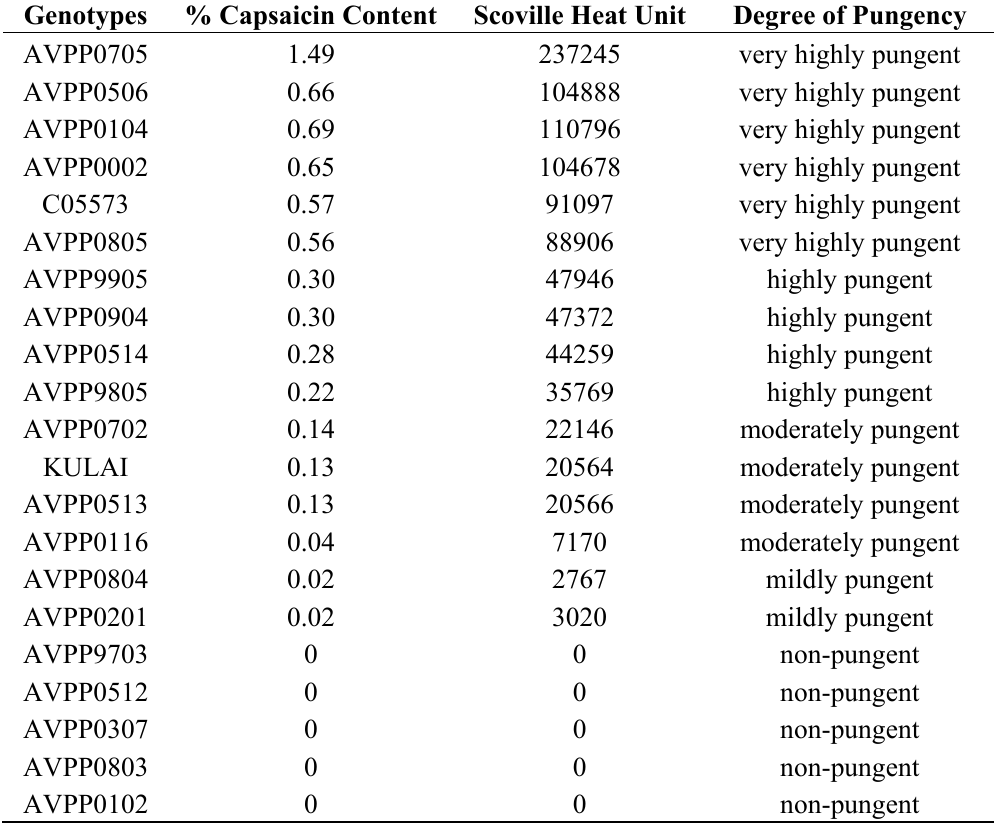
Table 6. The % capsaicin content, Scoville heat units, and degree of pungency of twenty-one chilli pepper genotype samples (dry